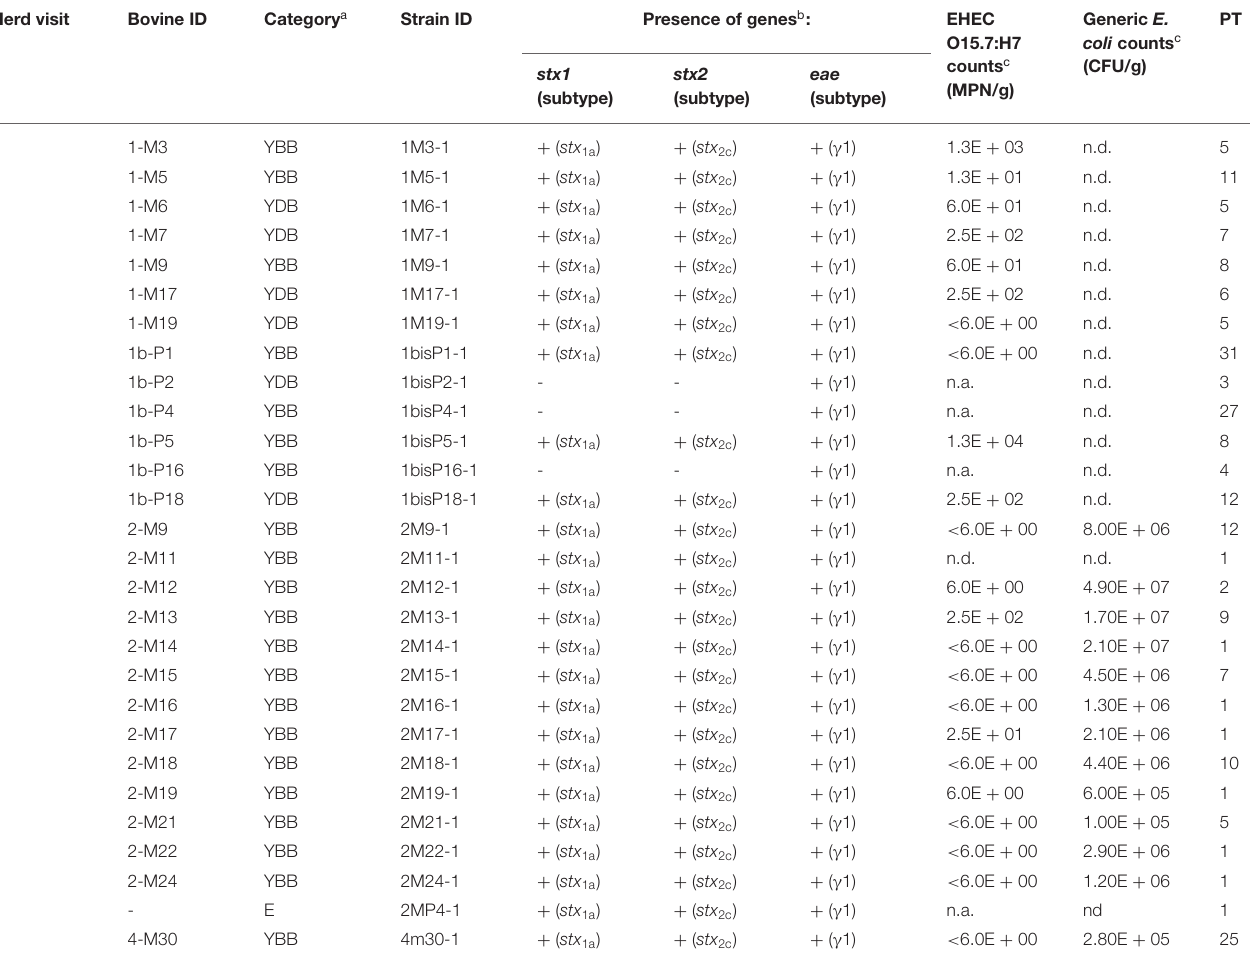
TABLE 3 | Origin, virulence profiles, counts, and PFGE types (PT) of enterohemorrhagic Escherichia coli (EHEC) and enteropathogenic Escherichia coli (EPEC) O157:H7 isolated from fecal or environmental samples and counts of generic Escherichia coli in farm